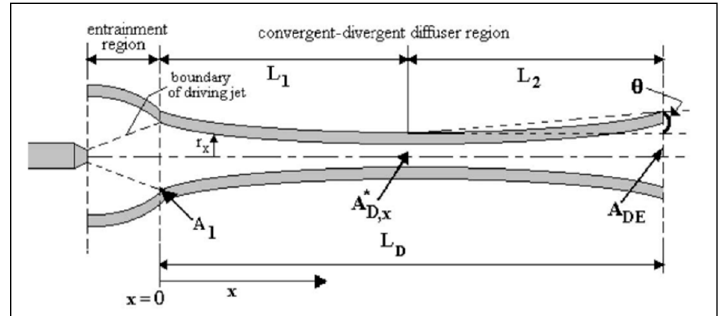
Figure 5. Constant rate of momentum change (CRMC) ejector [20].